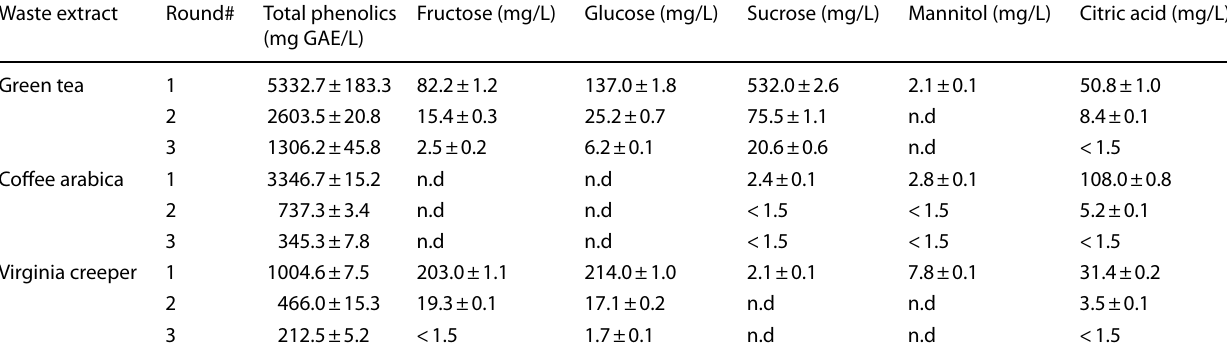
Table 1 Total phenolics, sugar, and citric acid content of extracts obtained by first, second, and third extraction rounds of green tea (GT1– GT3), coffee (CA1–CA3), and Virginia creeper (VC1–VC3)